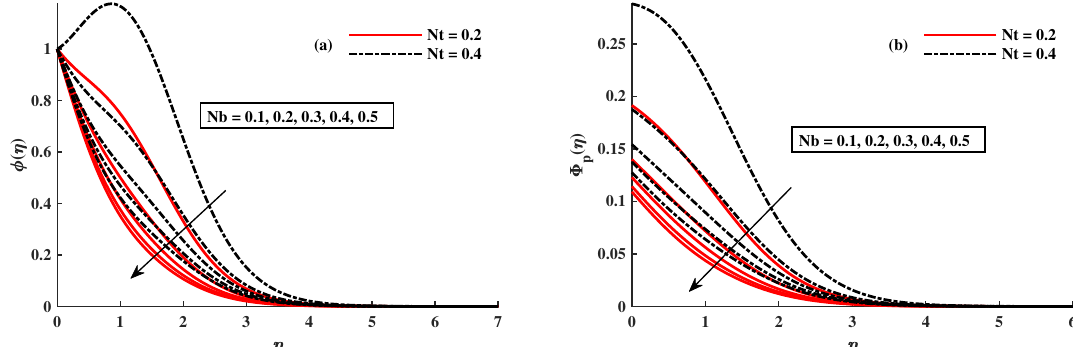
Figure 10. Variation of Nb to influence the fluid and dust concentration